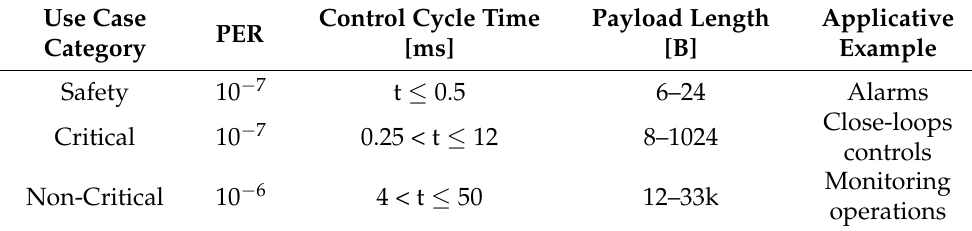
Table 1. Factory automation use